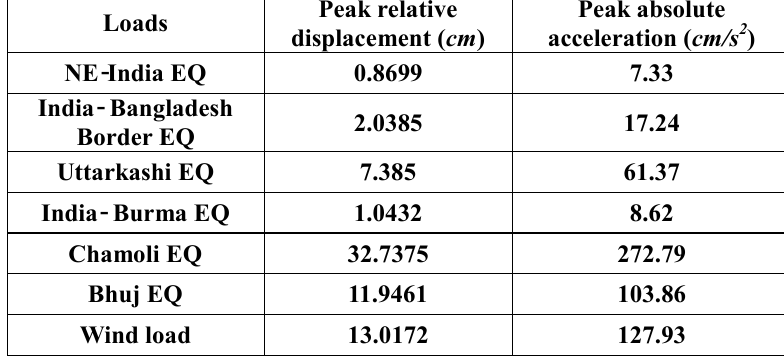
Peak relative displacement and peak absolute acceleration of TMD.